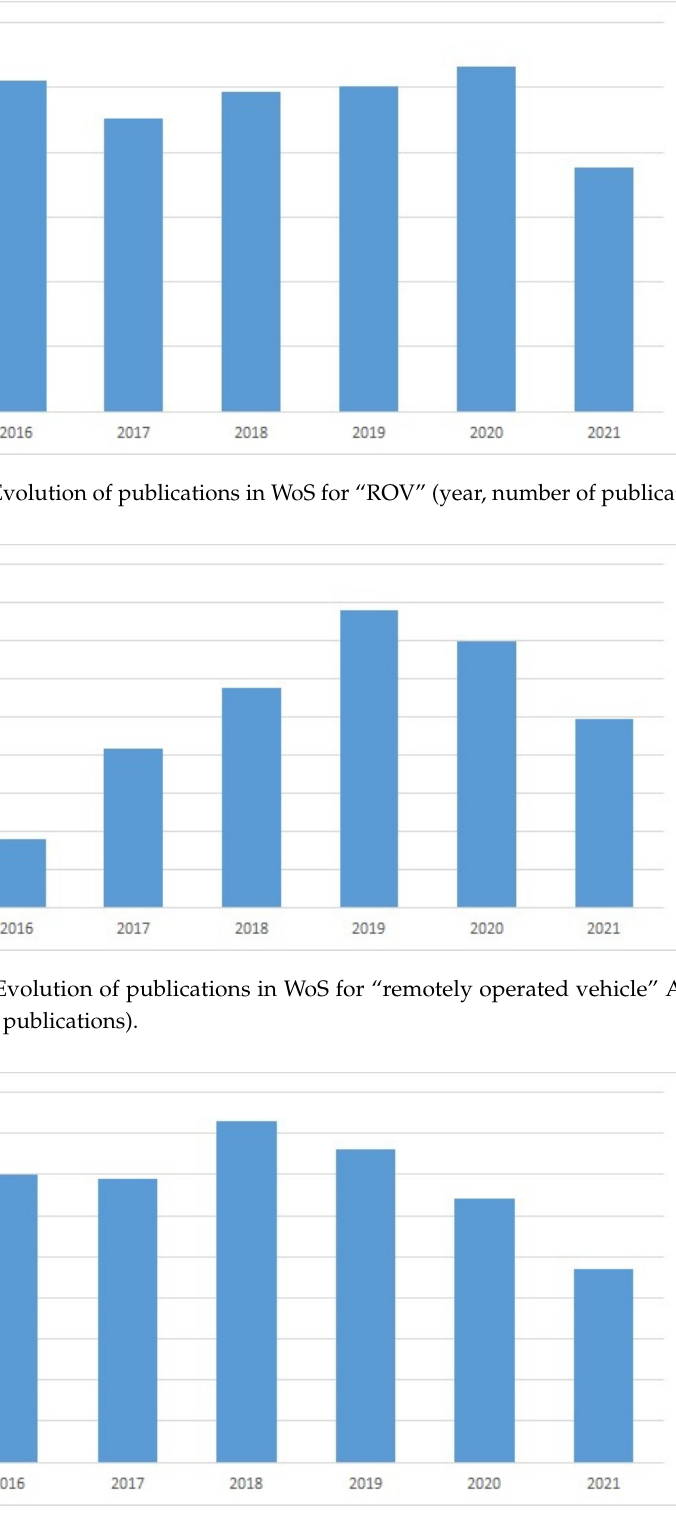
Figure 8. Evolution of publications in WoS for “remotely operated vehicle” OR “ROV” AND “de- sign” (year, number of publications). The results obtain evidence of the existence of research in the design and develop- ment of ROVs focused on specific requirements of the detailed design stage or on the def- inition and optimization of specific subsystems of the vehicle. No studies have been found that include and delve into the early stages of the project or the initial phases of the PDP.